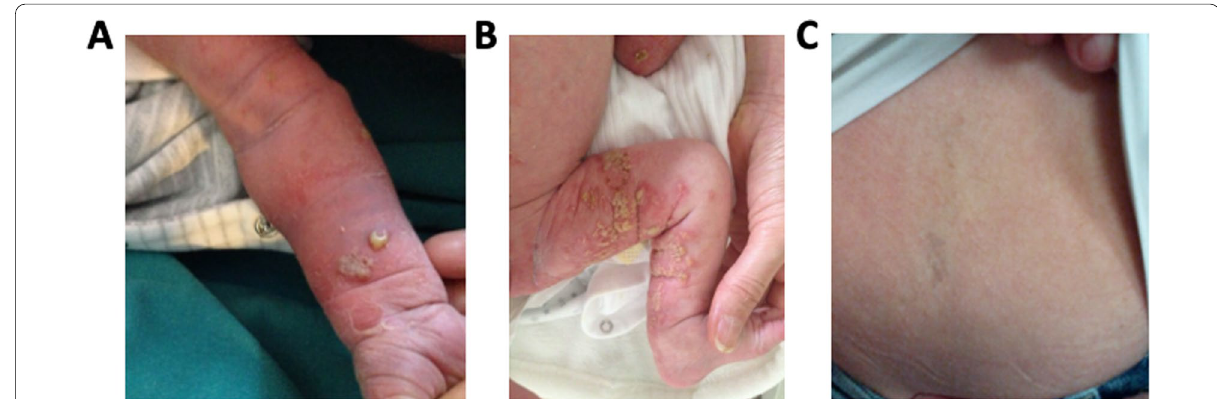
Fig. 1 Pictures of the patient and patients’ mother. A vesiculobullous rashes with an erythematous base on the arm of the patient, B verrucous, hyperkeratotic papules and plaques on the leg of the patient, C hypopigmented skin lesions of the mother